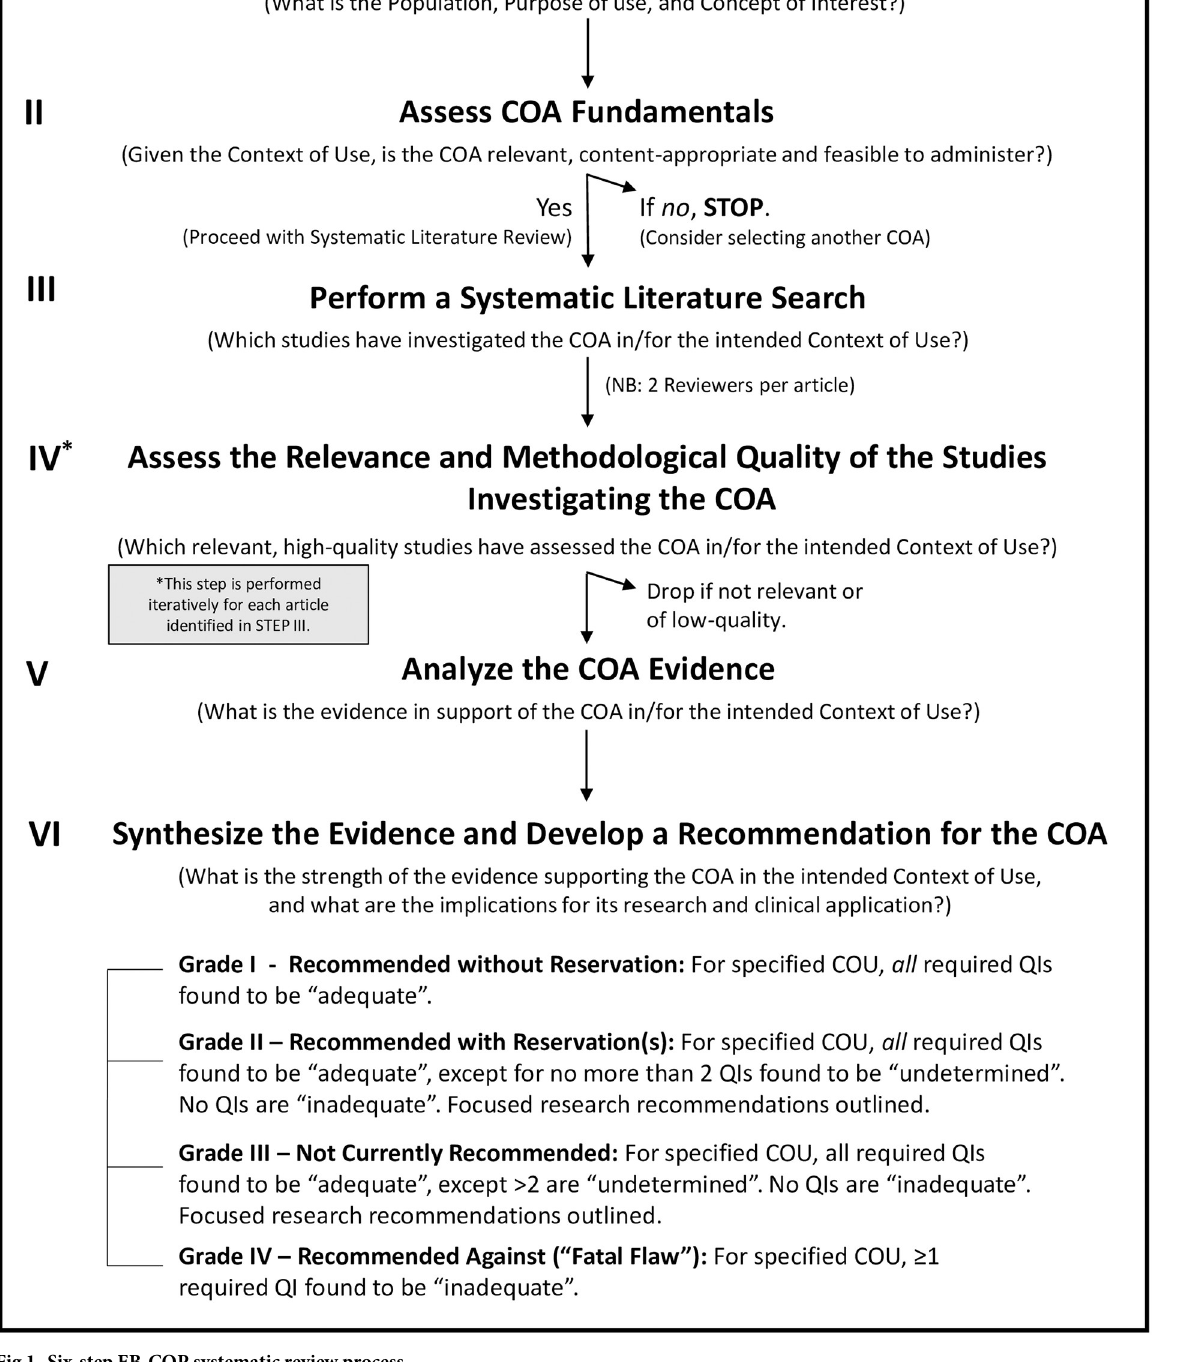
PLOS ONE | https://doi.org/10.1371/journal.pone.0242811 December14,